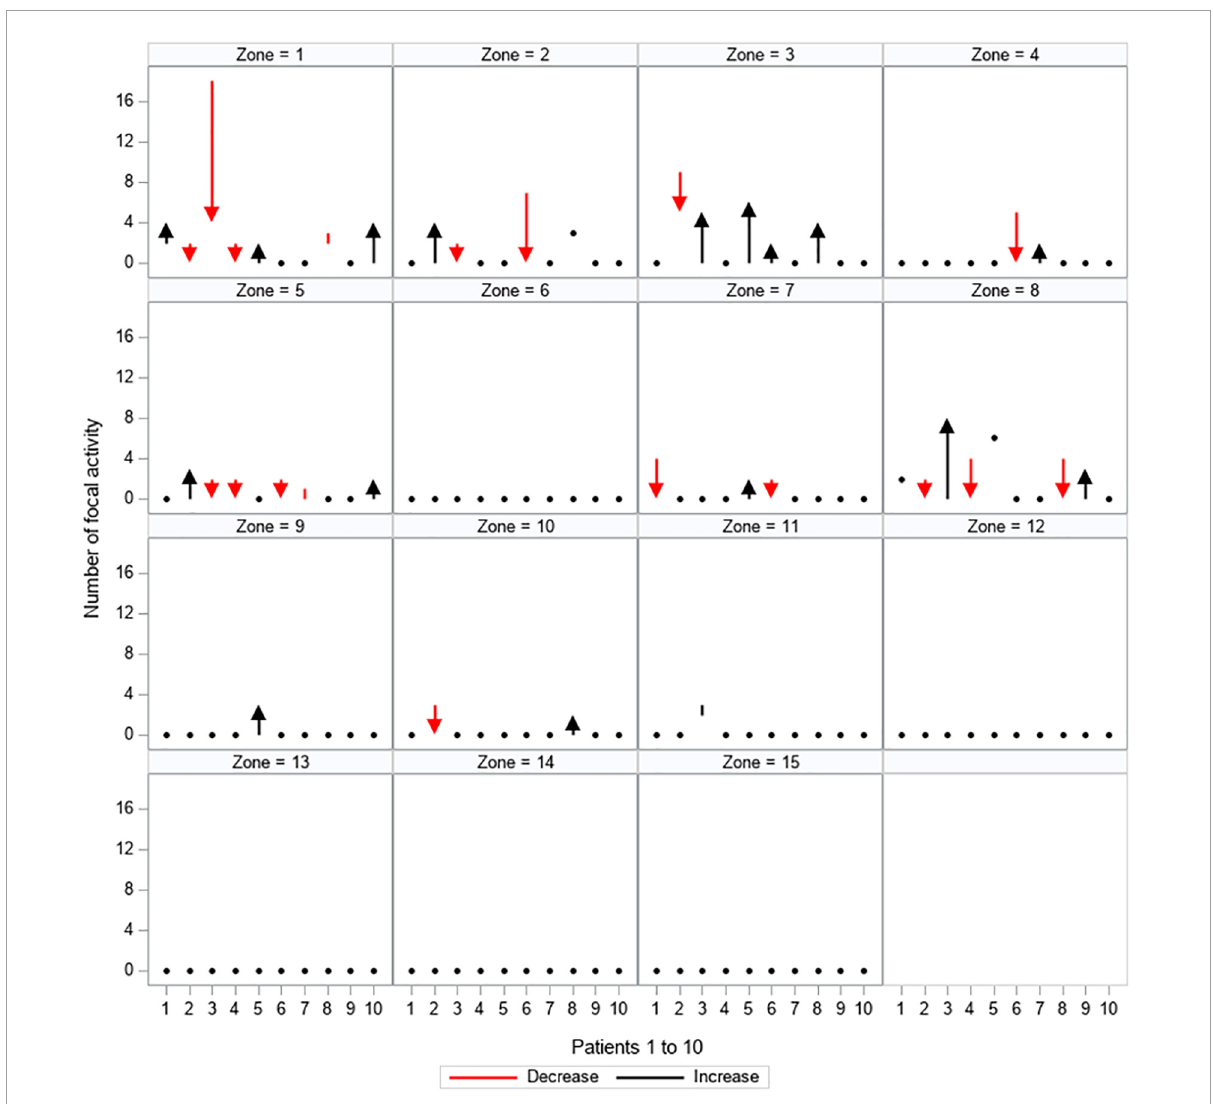
FIGURE5 Quantitative changes in focal activity. All 15 zones are depicted separately, showing the load of focal activity (y-axis) for every patient (patients 1–10 are displayed on the x-axis). The dynamic between the first and second mapping is shown: red arrows and lines represent a decrease in the amount of focal activity, black arrows and lines represent an increase in the amount of focal activity, black dots represent no change between the first and second